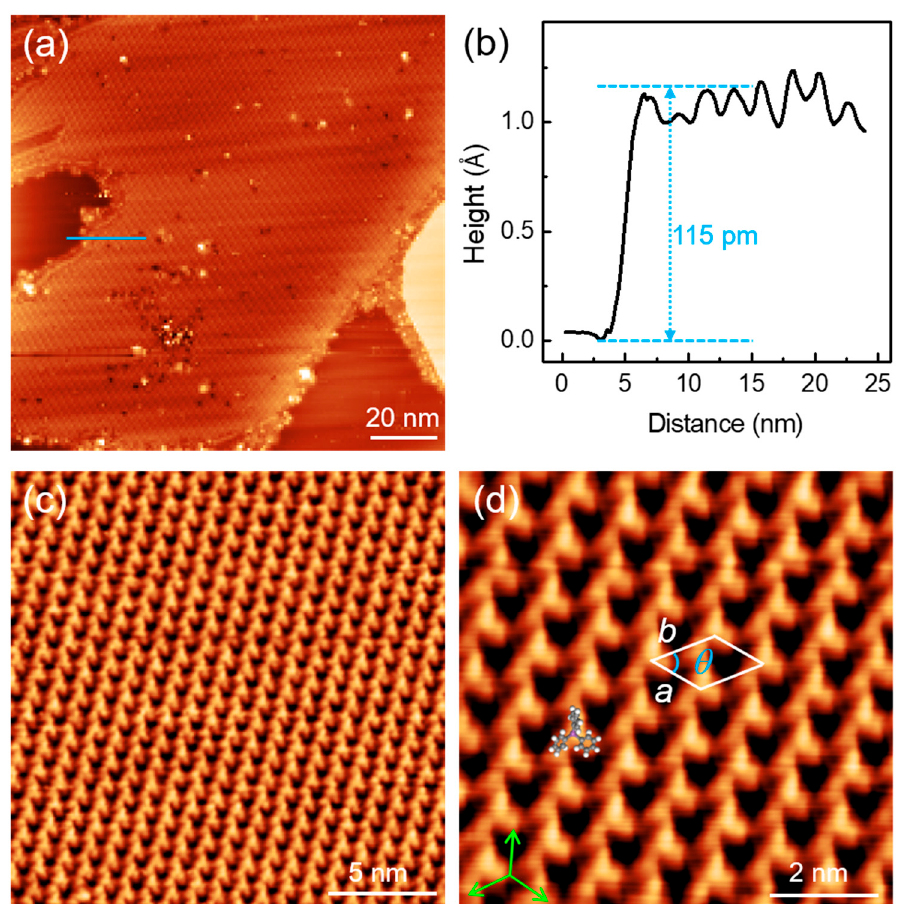
Figure 2. 2D self-assembly of TPB molecules on Cd(0001). ( a ) A monolayer island of self-assembled TPB formed on Cd(0001), 2.5 V, 30 pA. ( b ) Cross-sectional profile line taken along the blue line in ( a ), showing the apparent height of TPB layer. ( c , d ) Close-up views of the 2D self-assembly of TPB, showing an oblique lattice with 4 × √ 13 reconstruction, 0.1 V, 20 pA.